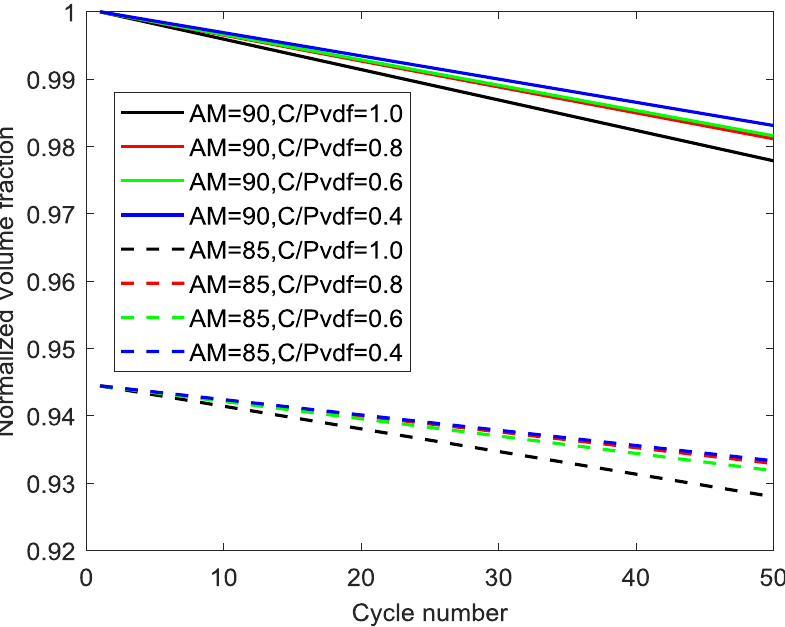
Figure 11. Normalized volume fraction of different samples.